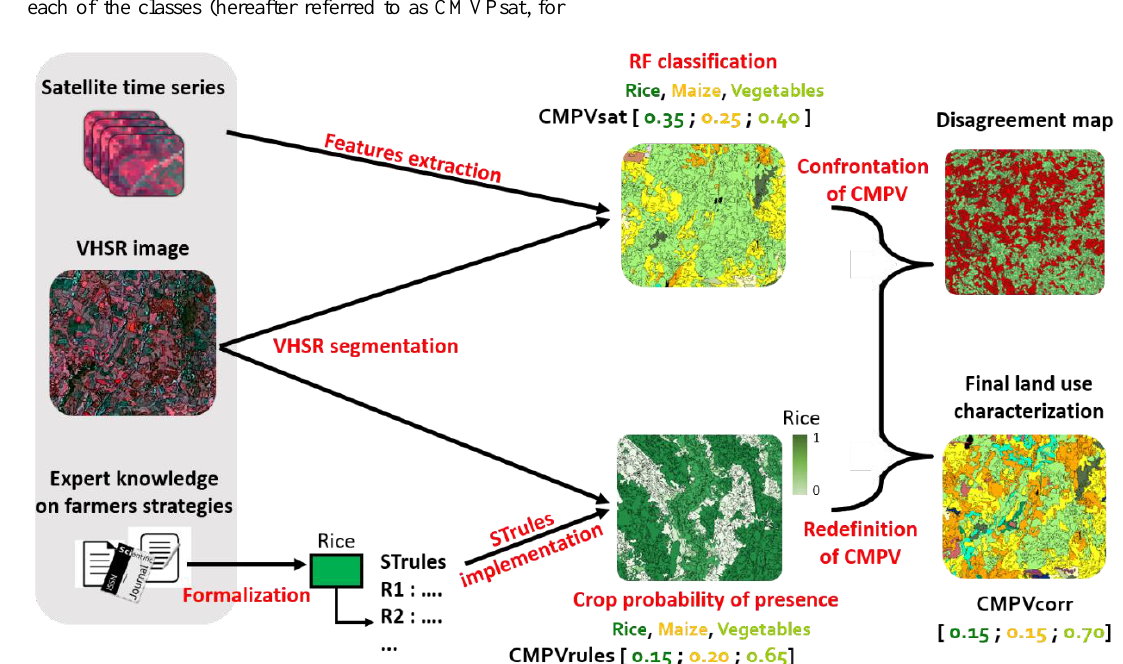
Figure 1: Framework of the method. The processes are presented in red color. CMVPsat corresponds to class membership vector probabilities obtained after random forest (RF) classification of satellite images. CMVPrules refers to the same vector obtained after spatio-temporal rules (STrules) implementation in the model. Finally, CMVPcorr presents the redefinition of the class membership vector probabilities from the two previous ones using fusion